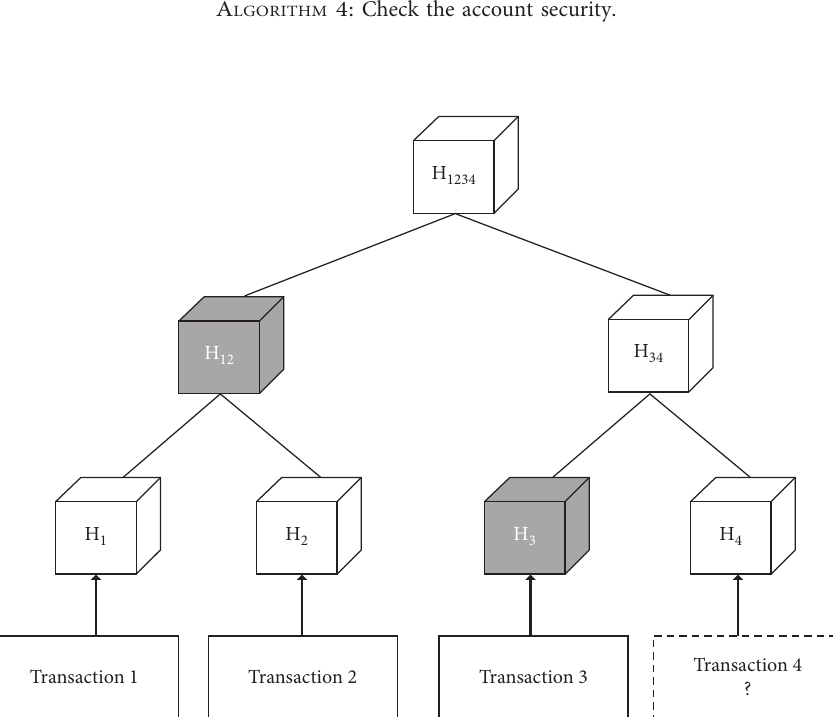
Figure 5: Supervision organizations verify transaction